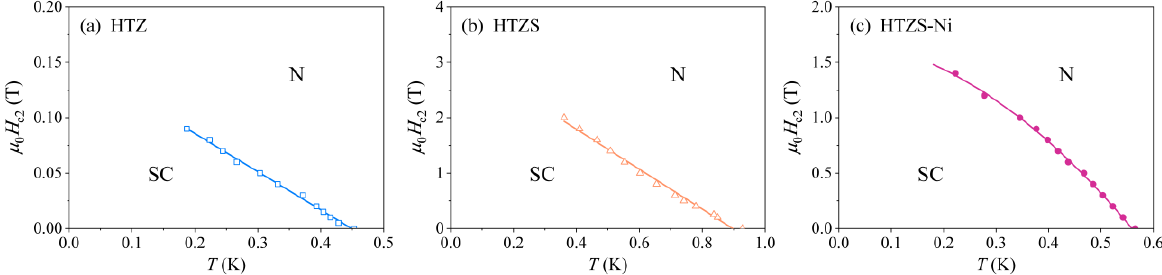
Figure 6. Temperature dependence of the upper critical field 𝐻 𝑐2 determined from the field-dependent specific heat for ( a ) HfTiZr (HTZ), ( b ) HfTiZrSn (HTZS), and ( c ) HfTiZrSnNi (HTZS-Ni) samples (N–normal region, SC–superconducting region). Solid lines in the panels ( a , b ) are linear fits, whereas the solid curve in panel ( c ) is the fit with the empirical function 𝐻 𝑐2 (𝑇) = 𝐻 𝑐2 (0)[1 − (𝑇 𝑇 𝐶 ⁄ ) 𝛼 ] with 𝛼 = 1.88 and 𝜇 0 𝐻 𝑐2 (0) = 1.8 T.